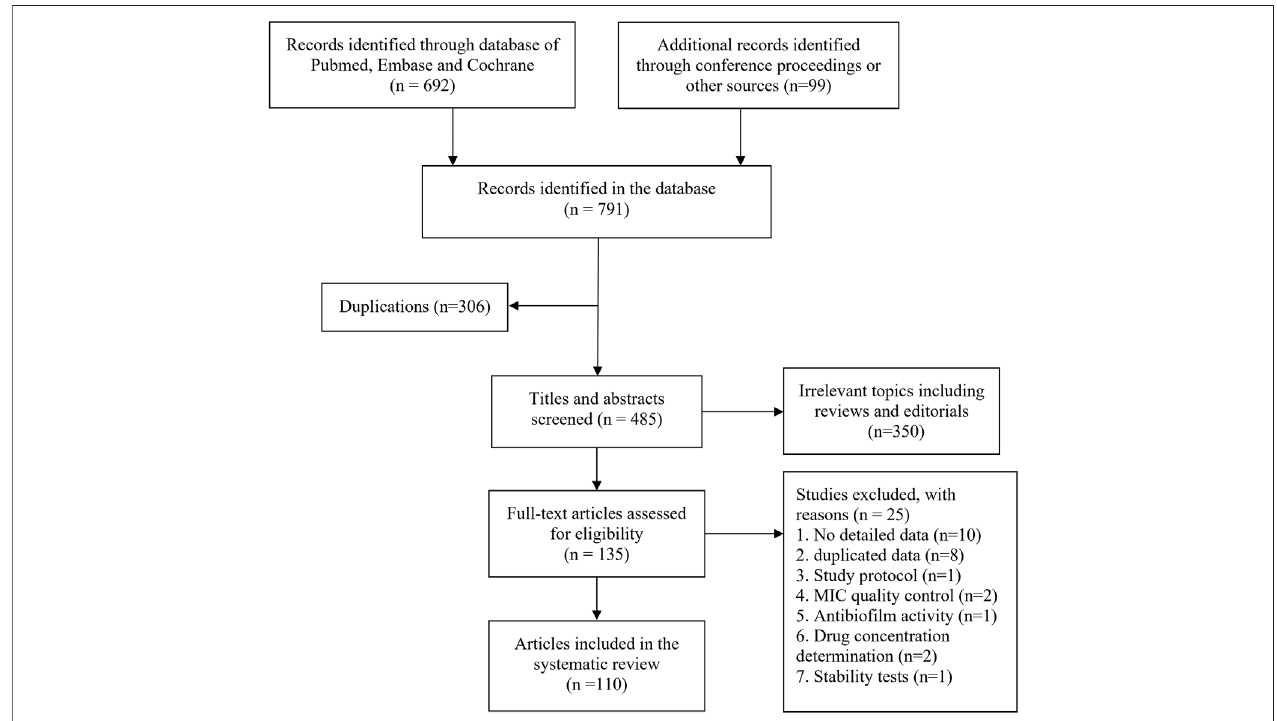
FIGURE 1 | Flow diagram of literature